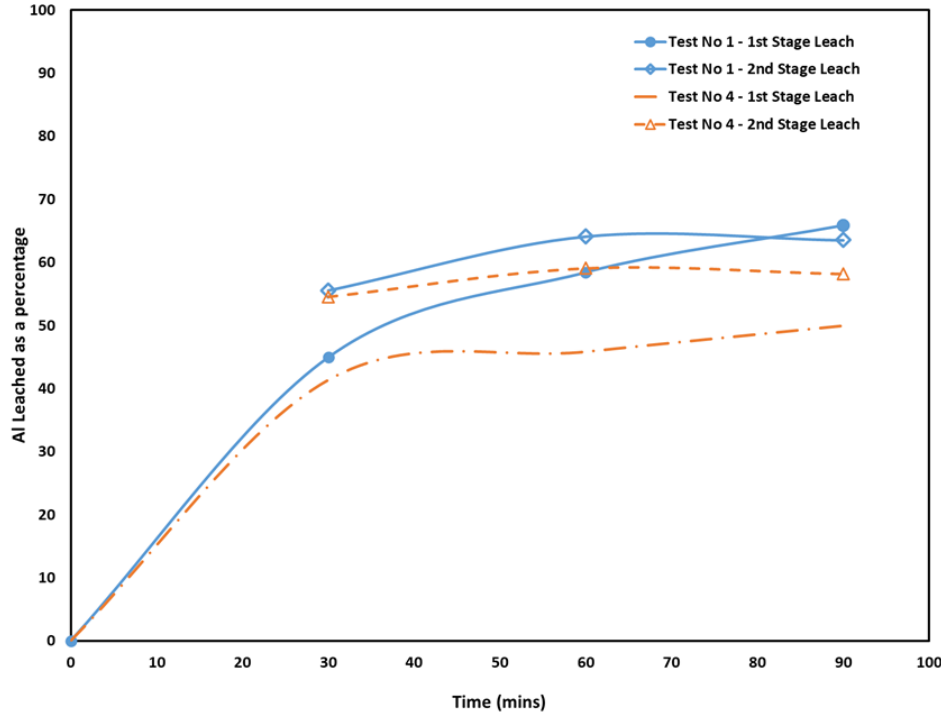
Figure 5 . Leach curves from test no. 1 (60 g/L Na 2 CO 3 ) and test no. 4 (100 g/L Na 2 CO 3 ). Figure 5. Leach curves from test no. 1 (60 g/L Na